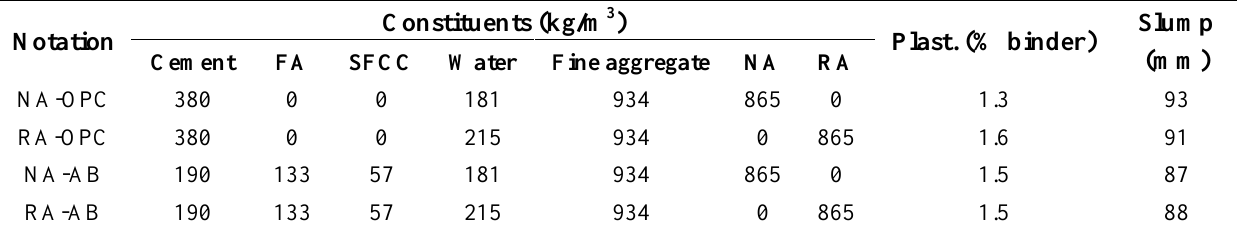
Table 3. Mix proportions for the concretes evaluated.